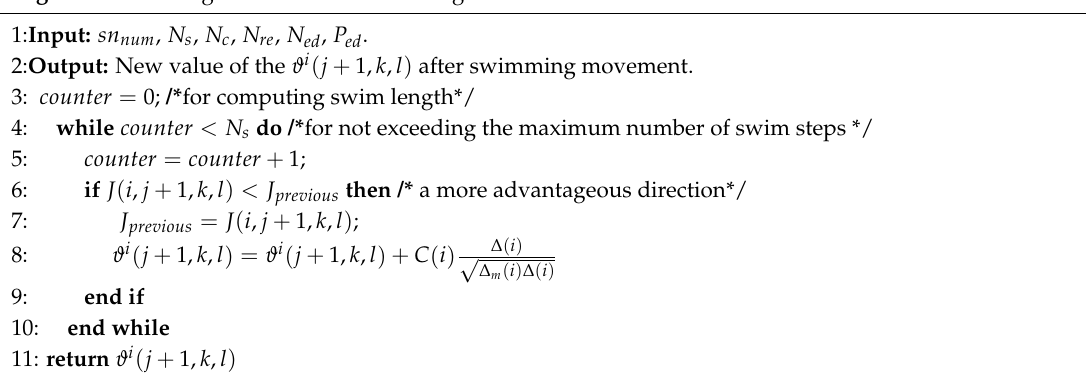
Algorithm 1: An algorithm for the swimming